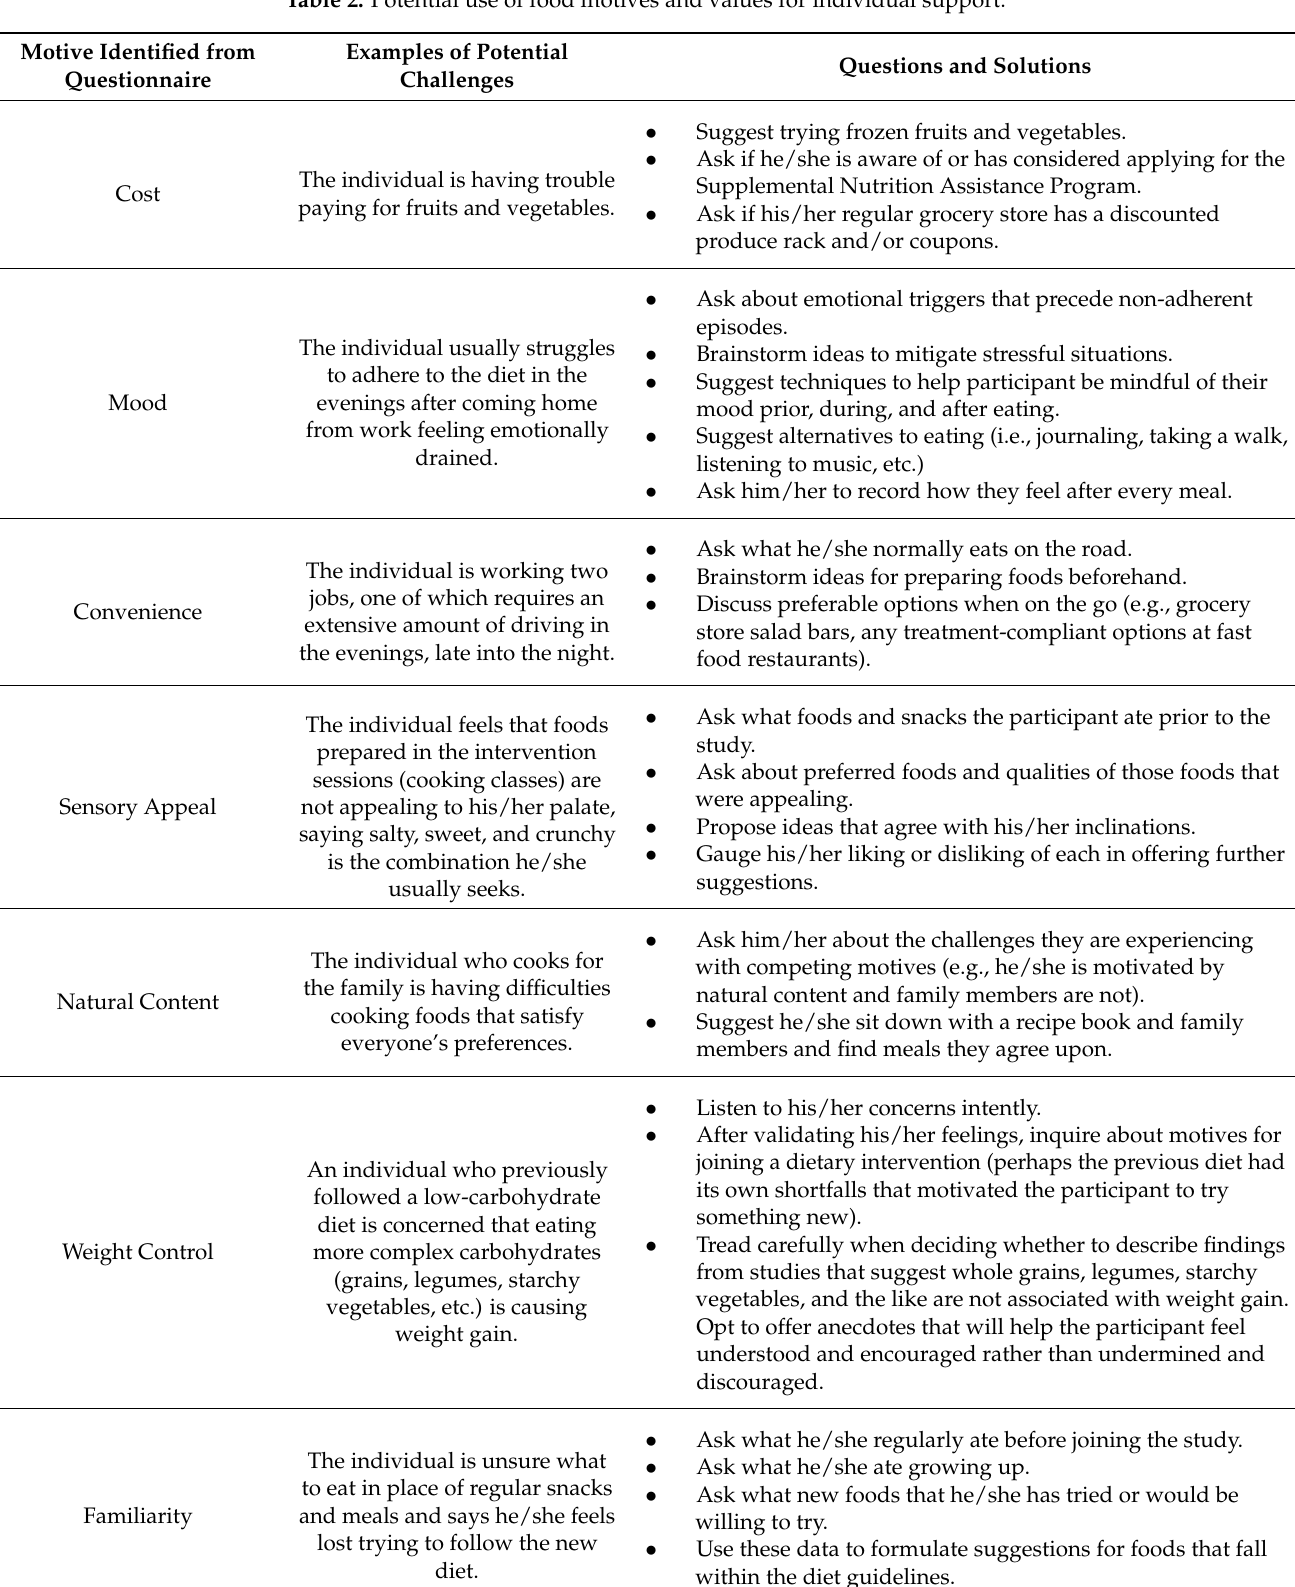
Table 2. Potential use of food motives and values for individual